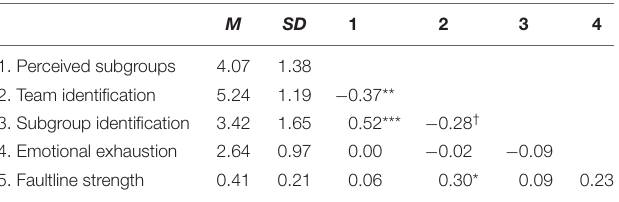
TABLE 2 | Means, Standard Deviations, and Zero-Order Correlations of Variables